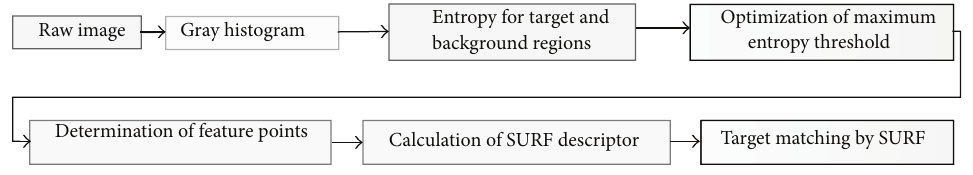
Figure 1: Flow chart of 2DMETS based SURF.